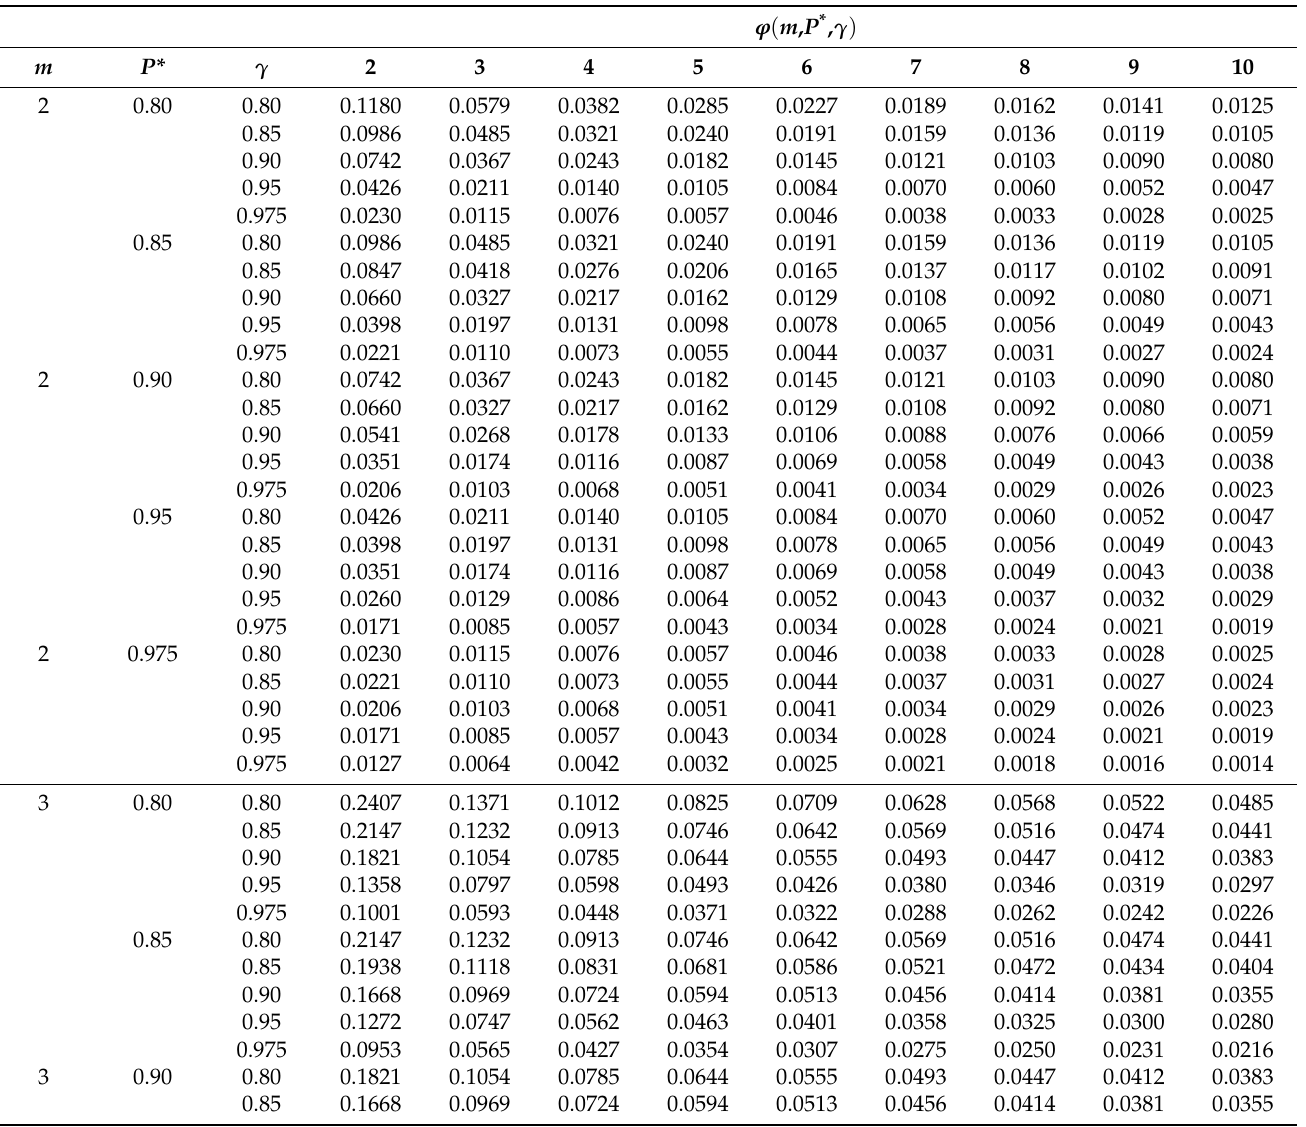
Table A1. The values of ϕ ( m , P ∗ , γ ) under P* = 0.80(0.05)0.95,0.975, γ = 0.80(0.05)0.95,0.975 and m